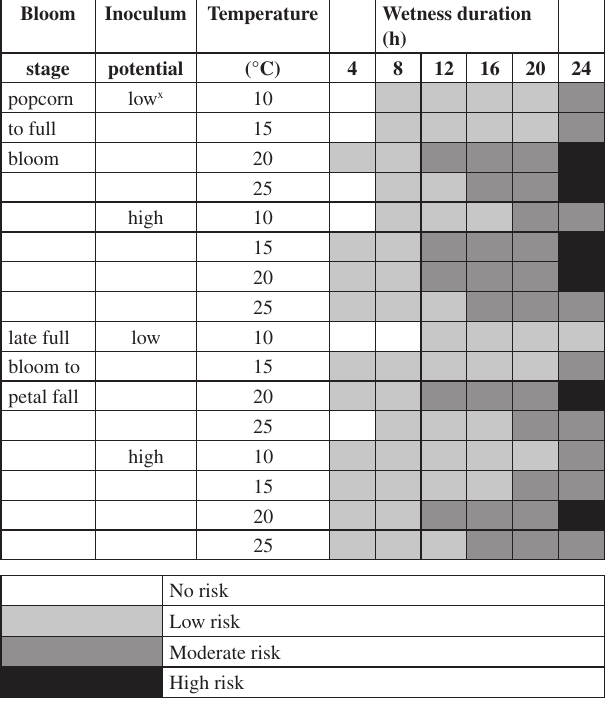
( Figure 2 ). Four recommendations for disease management were used: